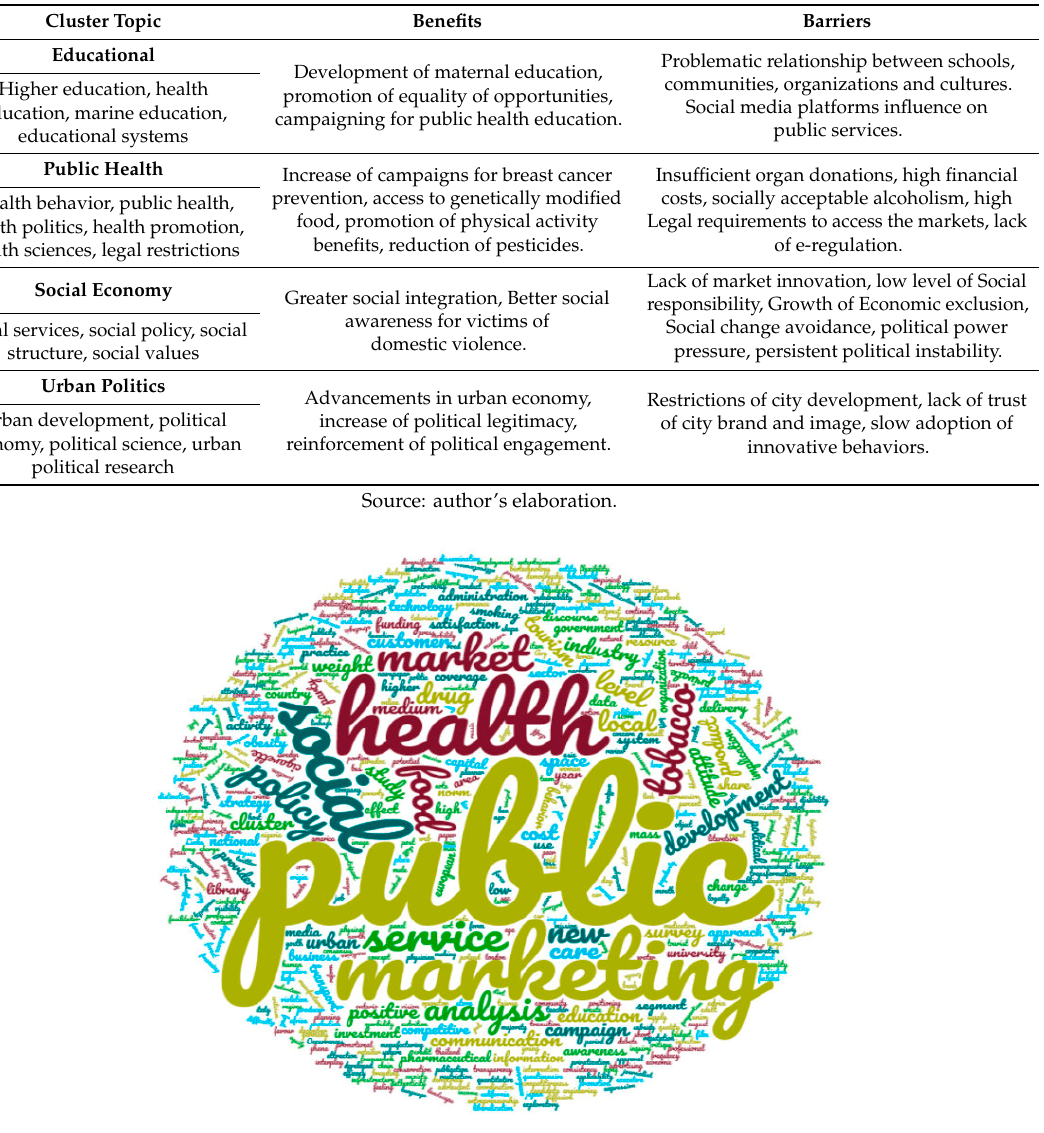
Figure 12. Word cloud critical key words. Source: author’s elaboration using wordle.net.